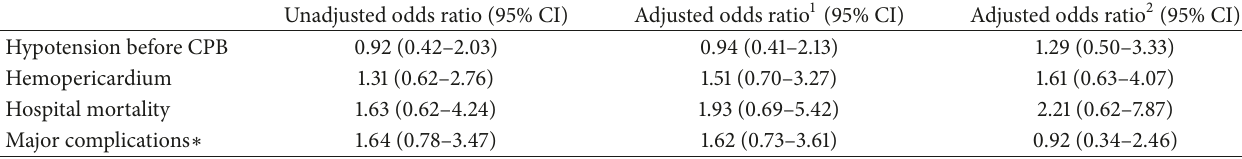
Table 5: Adjusted odds ratios for the association between interhospital transfer and intraoperative findings and outcomes.